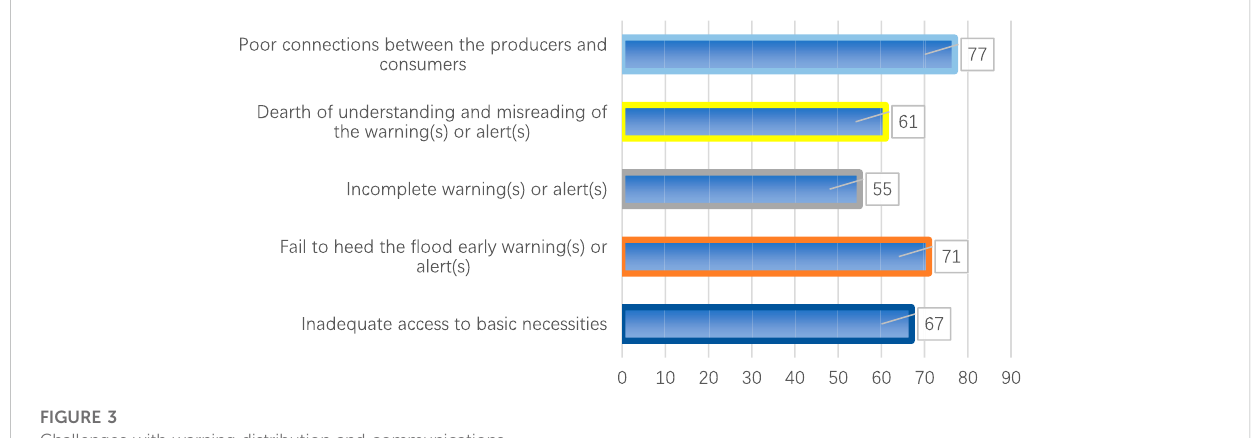
FIGURE 3 Challenges with warning distribution and